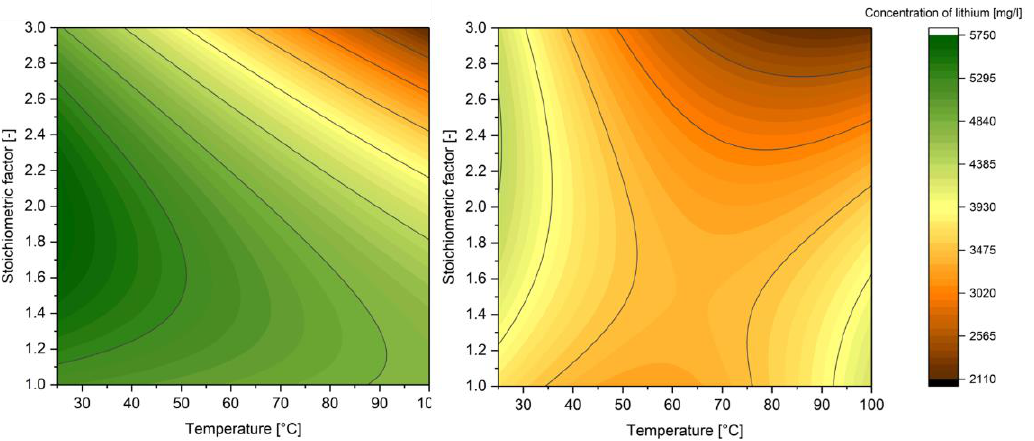
Figure 6. Statistical evaluation of the dissolved residual concentrations in mg · L − 1 of lithium starting from the synthetic ( left , 10,000 mg · L − 1 ) and authentic ( right , 5000 mg · L − 1 ) leaching solution using the precipitant Na 2 CO 3 as a function of temperature and the stoichiometric factor of the precipitant.